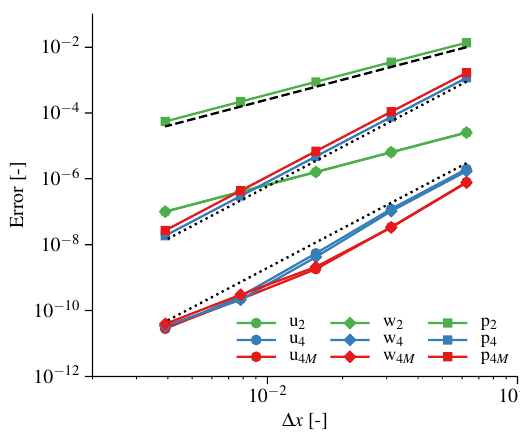
Figure 2. Convergence of the spatial discretization error in the two- dimensional Taylor–Green vortex. Subscript 2 indicates the second- order scheme, subscript 4 the most accurate fourth-order scheme, and subscript 4 M the fully energy-conserving fourth-order scheme. The dashed black line is the reference for second-order conver- gence; the dotted black lines indicate fourth-order convergence.